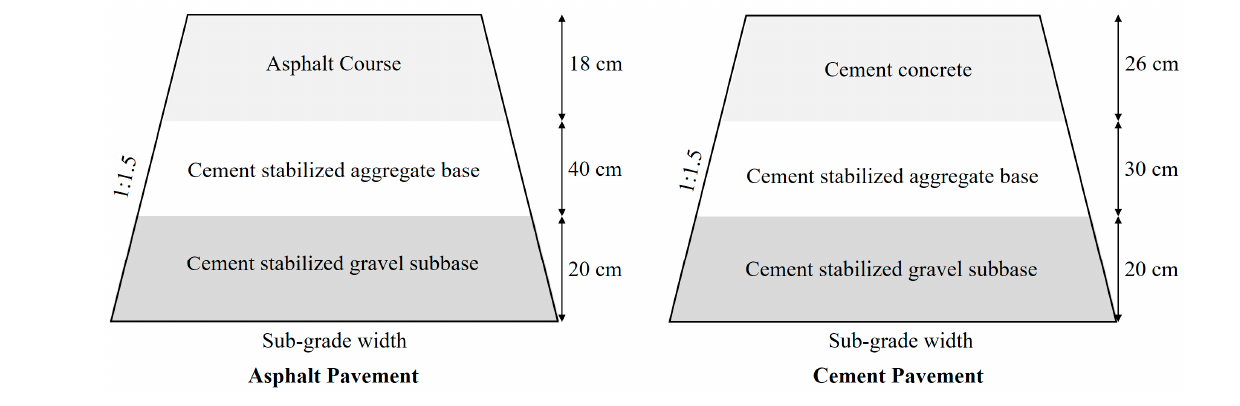
Figure 2. Typical structure of asphalt and cement pavement. Table 1. Road structure in China.